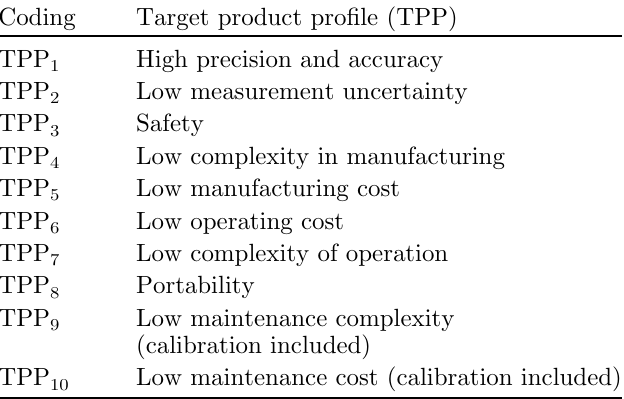
Table 1. Target product pro fi le (TPP) associated with the measuring system for biomedical application.